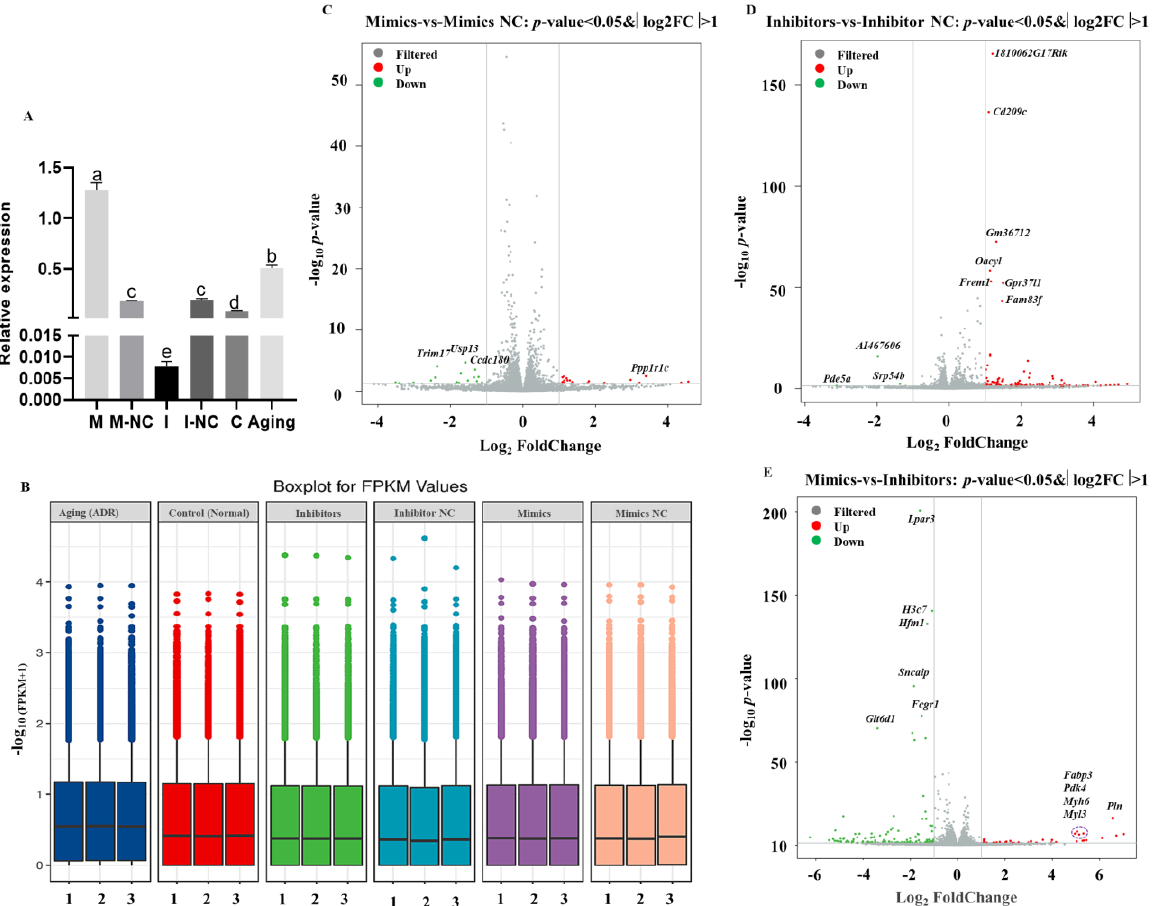
Figure 4. Differentially expressed genes (DEGs) identified by RNA-seq after transfection of tRF-Trp- CCA-014 in mouse NIH3T3 cells. ( A ) The expression level of tRF-Trp-CCA-014 in Mimics, Mimic NC, Inhibitors, Inhibitor NC, Aging (adriamycin (ADR)), and Control (Normal) groups; ( B ) boxplot for FPKM values in different groups; ( C – E ) the significantly up/downregulated DEGs among Mimics vs. Mimic NC groups, Inhibitors vs. Inhibitor NC groups, and Mimics vs. Inhibitors groups. In ( A ), different small letters indicate significant differences at p < 0.05